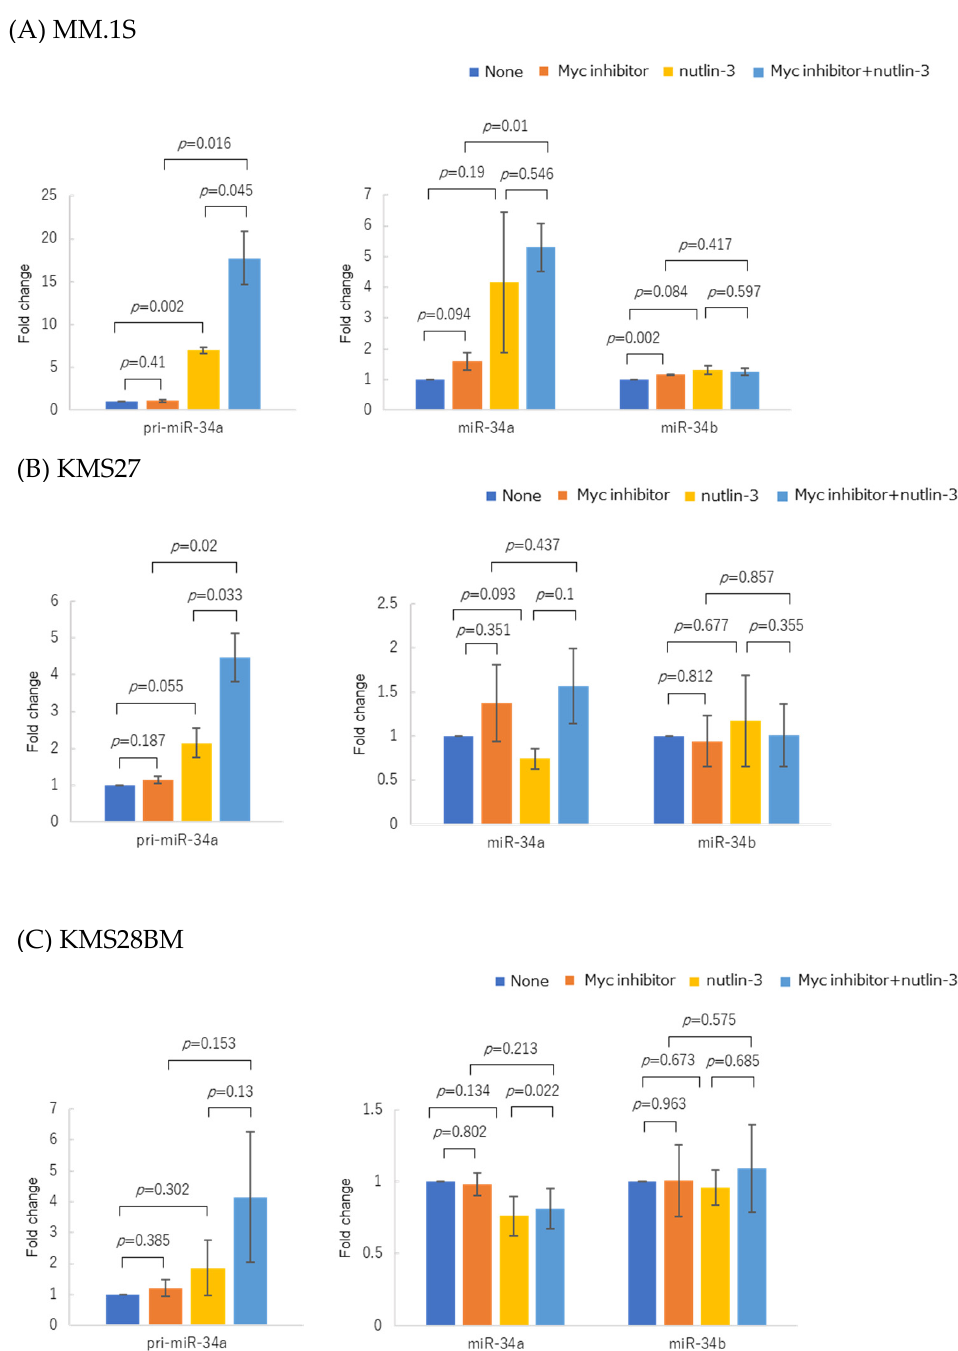
Figure 6. Changes in pri-miR-34a and mature miR-34a/b expressions in three myeloma cell lines after treatment with Myc inhibitor 10058-F4 and nutlin-3. ( A ) MM.1S, ( B ) KMS27, and ( C ) KMS28BM were treated with 20 µ M of Myc inhibitor. MM.1S was treated for 48 h with 1 µ M nutlin-3, while the other two cell lines were treated for 72 h with 10 µ M nutlin-3. Experiments were performed in triplicate. Error bars show the standard deviation (SD) within triplicated experiments. Blue, no treatment; orange, with 20 µ M of Myc inhibitor; yellow, with 1 or 10 µ M of nutlin-3; light blue, with co-treatment of Myc inhibitor and nutlin-3. Blue and yellow bars show the same data as in Figure 2. Blue and orange bars show the same data as in Figure 5.